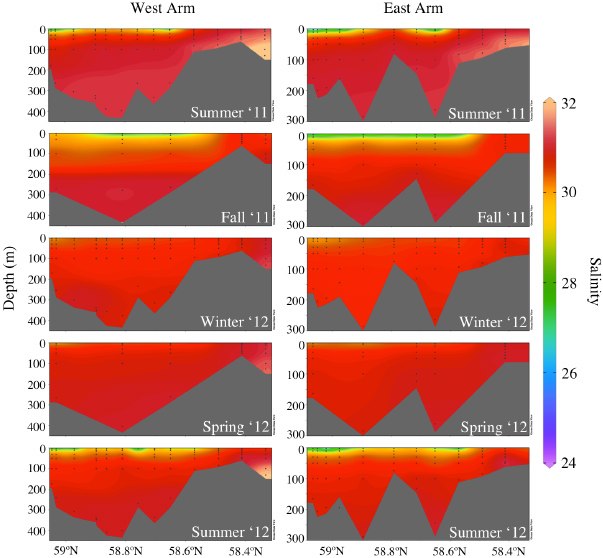
Figure 4. Spatial and seasonal distribution of DIC in the water col- umn. Contours represent nitrate